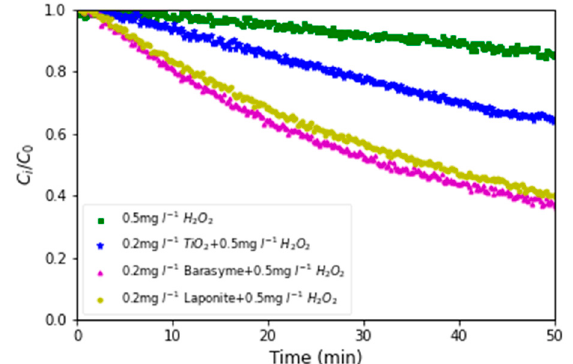
Figure 6. Photodegradation of a 21.2 μ M (5 mg L − 1 ) carbamazepine under UVC irradiation, with 0.5 mg L − 1 H 2 O 2 alone or combined with 0.2 mg L − 1 TiO 2 , barasym or laponite.